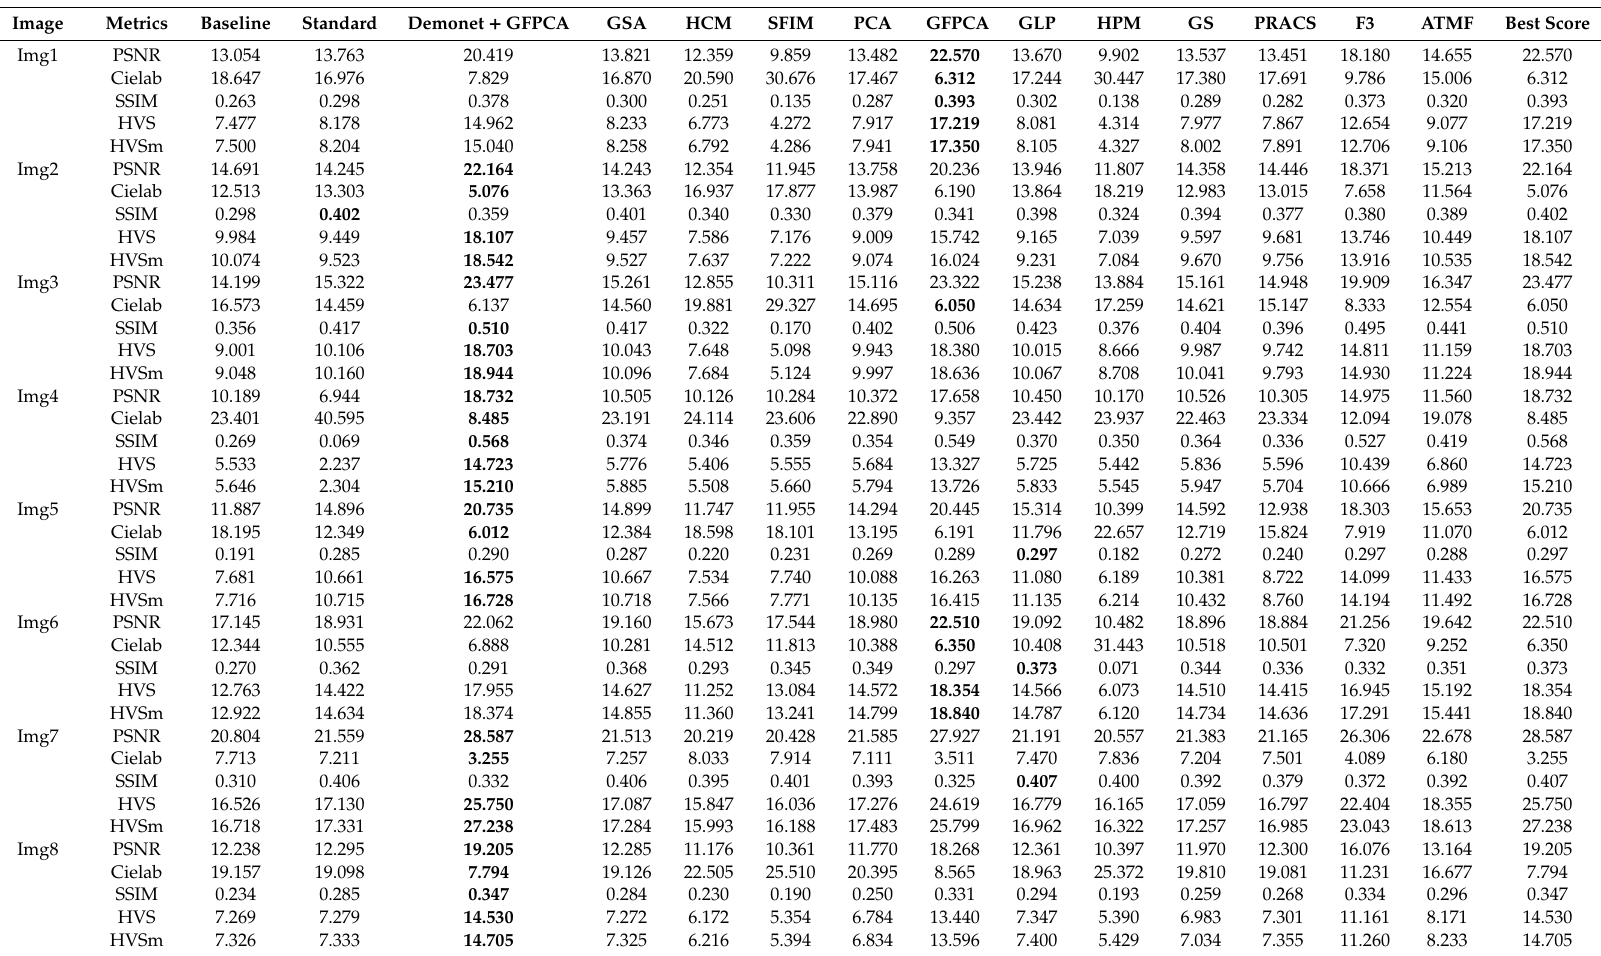
Table A4. Performance metrics of 14 algorithms at 10 dBs SNR (Poisson noise). Bold numbers indicate the best performing methods in each row. Bold numbers indicate the best performing methods in each row. Red numbers indicate those methods used in F3 and those red and green numbers indicate those methods used in